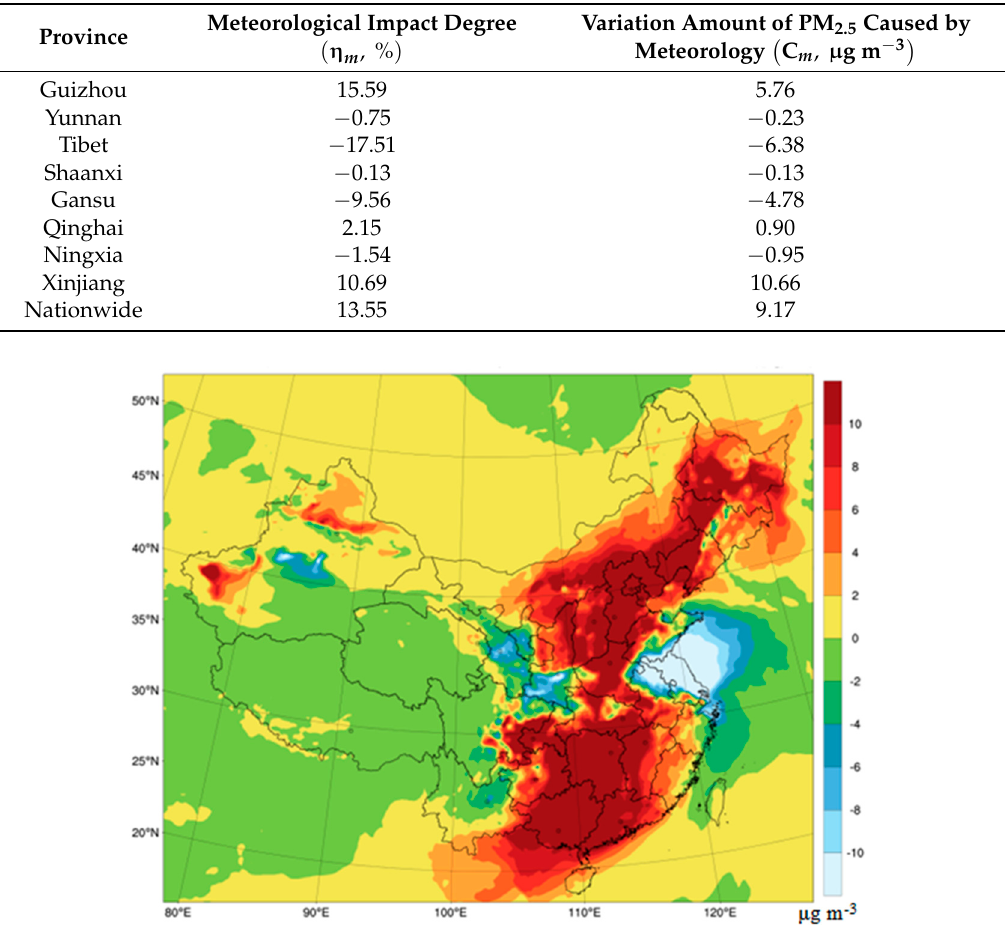
Figure 6. Changes in the average PM 2.5 concentration (January 2017 values–January 2016 values) caused by meteorological factors.